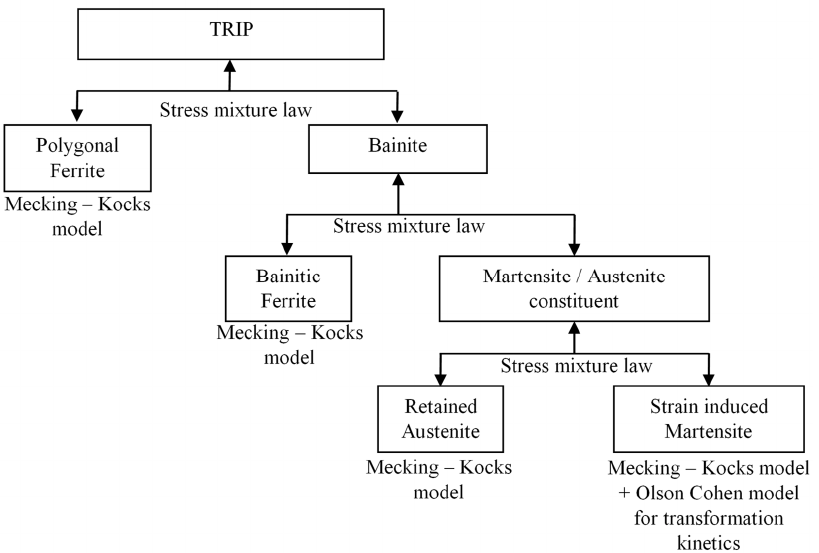
Figure 1. Scheme of the multiscale constitutive stress-strain model for complex multiphasic low-alloy TRIP steels proposed by Bouquerel et al. based on individual constituents